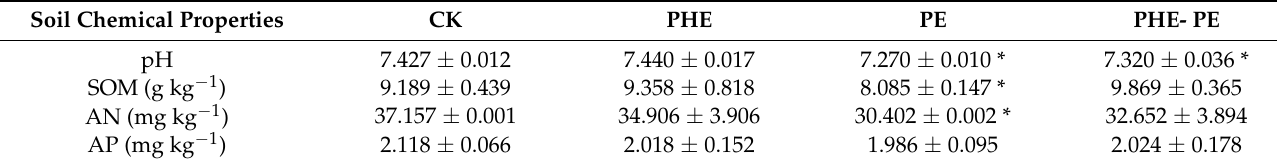
Table 1. The soil chemical properties of all samples.